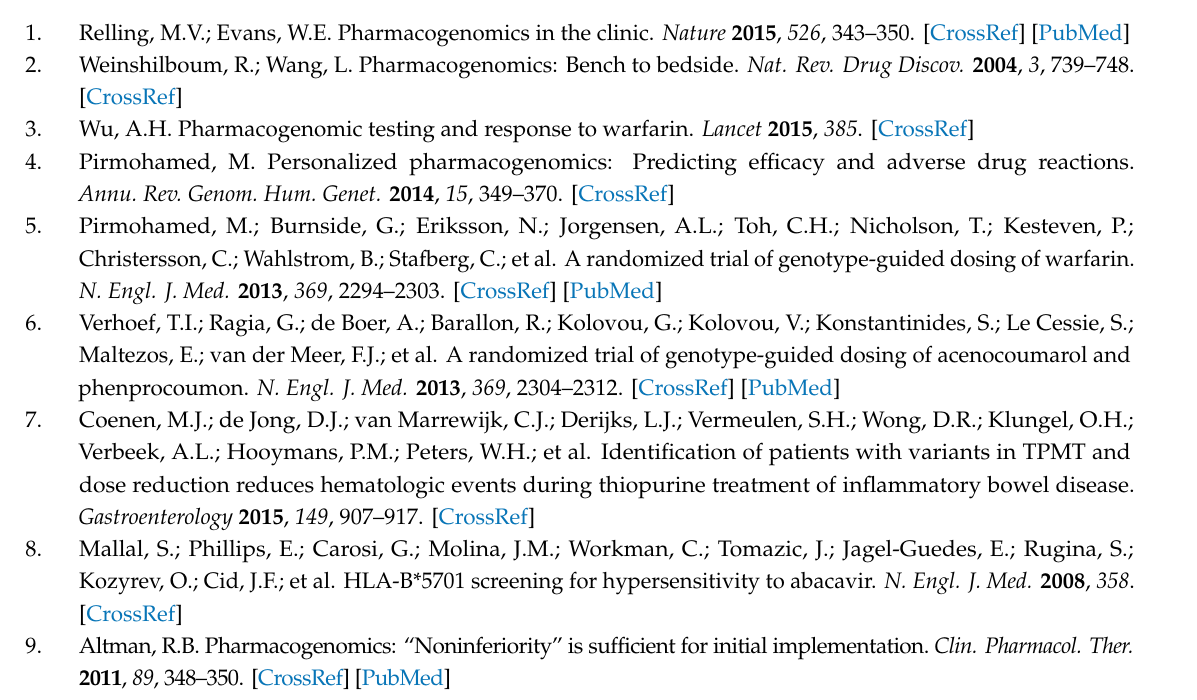
Table S1: The tested PGx Panel in the IP3 pilot study. Table S2: Actionable drug-gene interactions relevant to the panel used. Table S3: Pre-defined drug-gene associated adverse drug reactions based on literature underlying the DPWG. Figure S1: Example report sent to physicians and